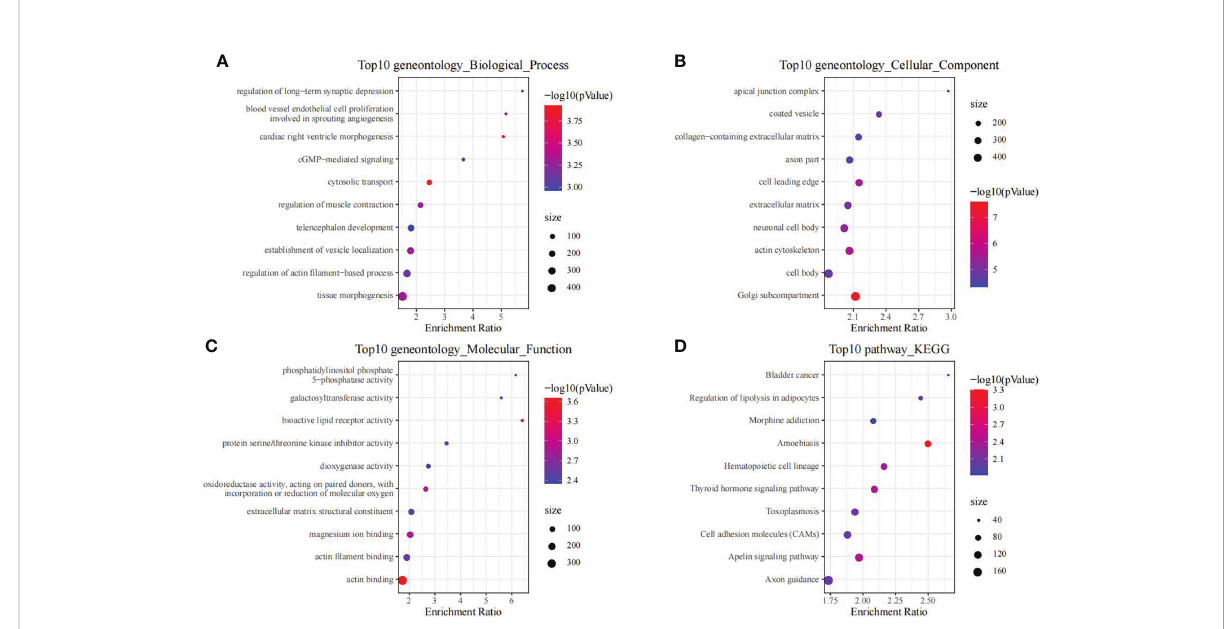
FIGURE 3 The functional analysis of genes in black module. GO biological process (A) , GO cellular component (B) , GO molecular function (C) and KEGG (D) enrichment analysis of genes in the black